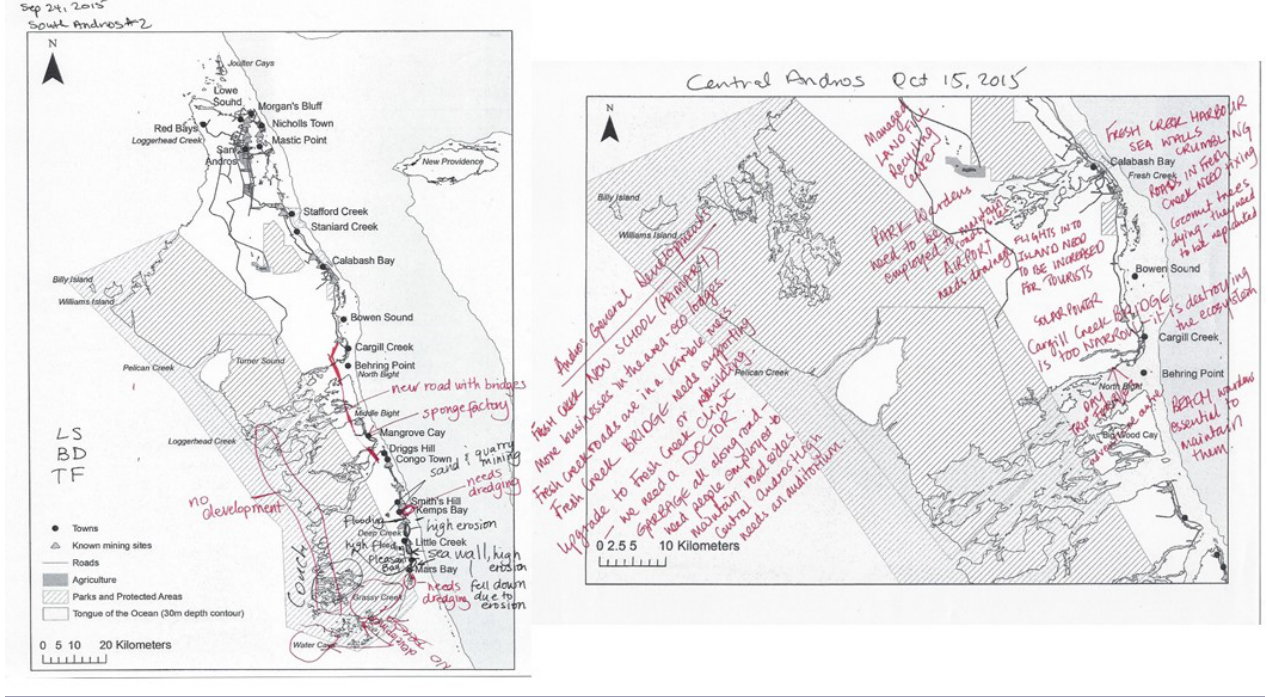
Fig. 4 . Examples of participatory mapping. Black annotations indicate the location of current activities or environmental stressors: for example, areas of erosion and flooding (left) and bonefish lodges. Red annotations indicate the location of desired future activities: for example, bridges across the central bights (left) and areas not to disturb (both). The mapping exercise also elicited ideas for the future that were not spatial: for example, the need for doctors, schools, and park wardens